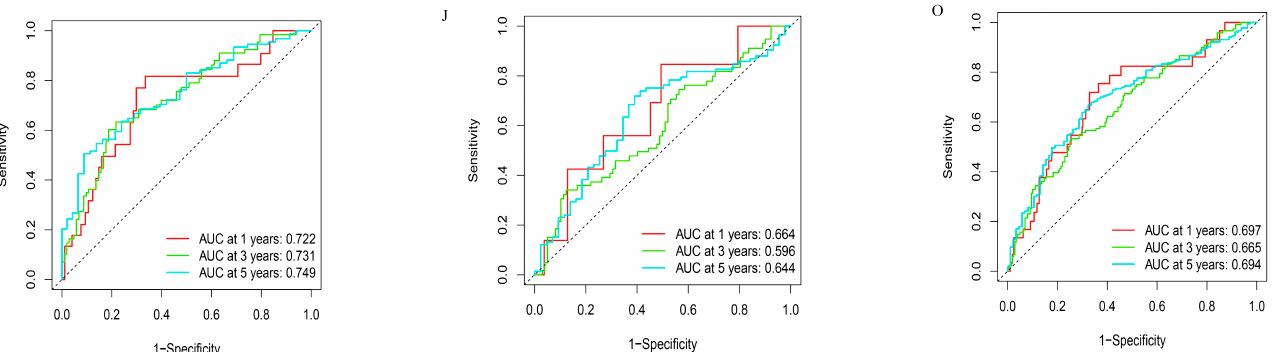
Figure 2. Assessment of prognosis-related protein model for overall survival (OS). ( A ) Kaplan – Meier survival curve of OS between high- and low-score groups in the training, testing ( F ), and whole ( K ) sets. ( B ) The distribution of the risk score of prognosis-related proteins in the training, testing ( G ), and whole ( L ) sets. ( C ) The distribution of survival status of prognosis-related proteins in the training, testing ( H ), and whole ( M ) sets. ( D ) The expression level of prognosis-related proteins in the training, testing ( I ), and whole ( N ) sets. ( E ) ROC curve for 1-year, 3-year, and 5-year survival rates in the training, testing ( J ), and whole ( O ) sets.